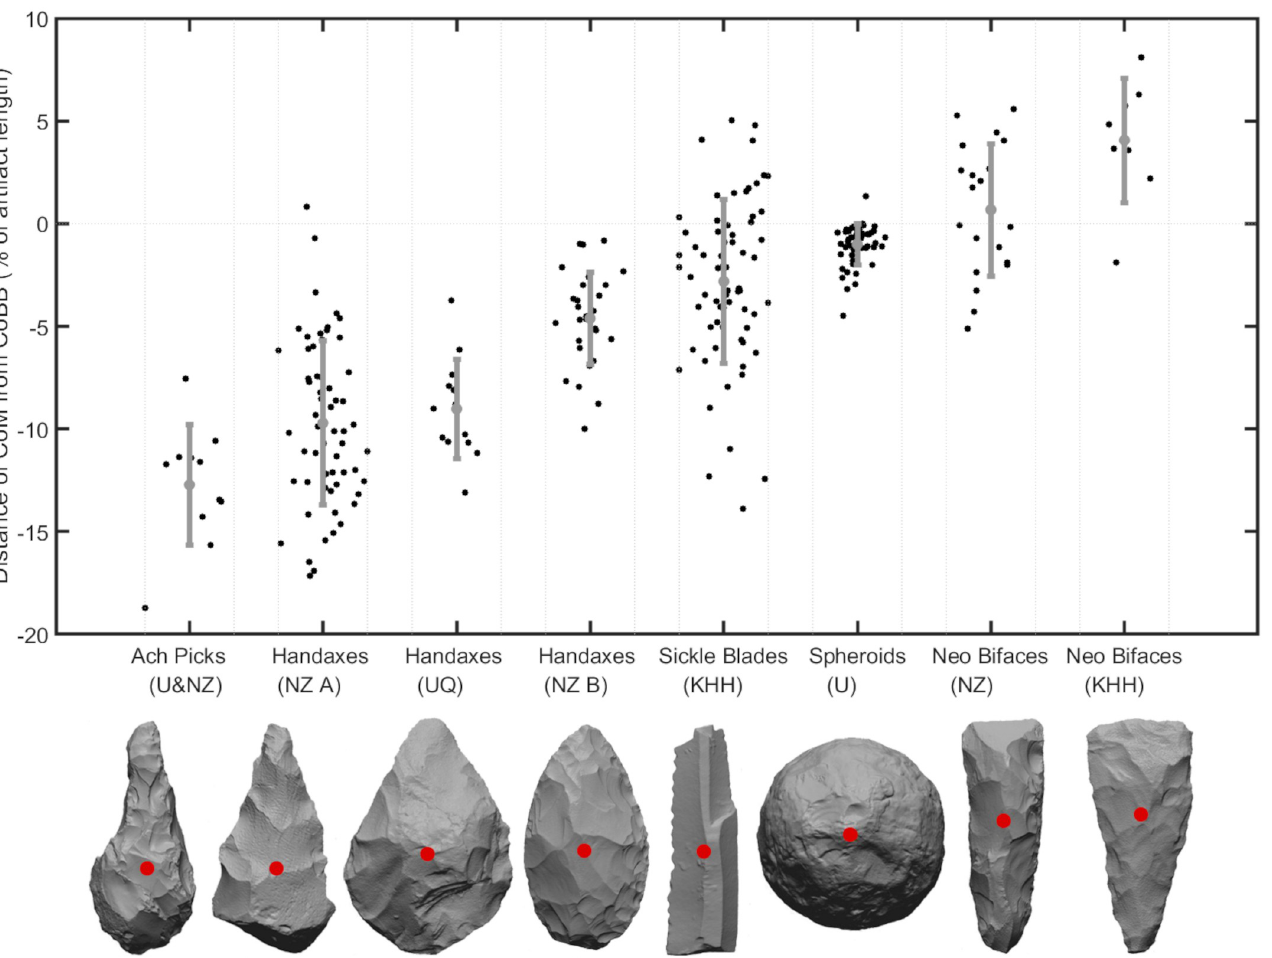
Fig 3. Jitter plot comparing the CoM with the CoBB for (in order) picks from Ubeidiya and Nahal Zihor, handaxes from Nahal Zihor Group A, handaxes from Um Qatafa, handaxes from Nahal Zihor Group B, sickle blades from Kfar HaHoresh, Spheroids from Ubeidiya, Neolithic bifaces from Nahal Zihor, and Neolithic bifaces from Kfar HaHoresh. The y-axis shows the difference in y-coordinates, and the x-axis shows the difference in x-coordinates, normalized by artifact length and width respectively. Grey vertical lines show the maximum variation in CoM and CoBB x-coordinates. The mean values and standard deviation error bars are shown in